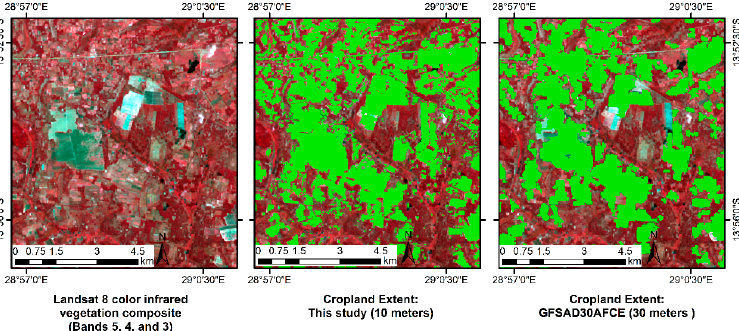
Figure 6. Comparison of cropland maps from this study and the GFSAD30AFCE at one subset.